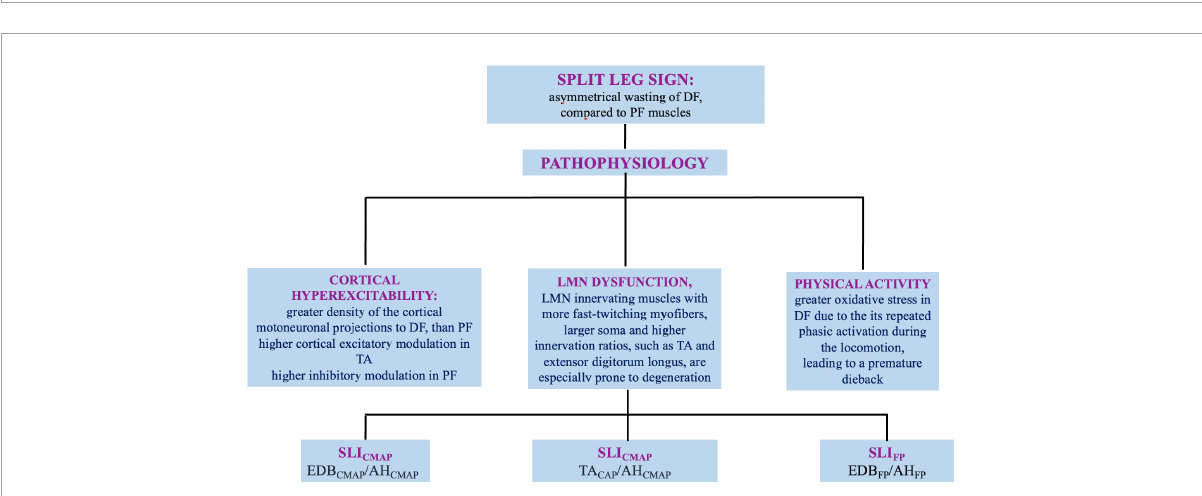
FIGURE2 Split leg sign in ALS: definition, pathophysiology, and neurophysiologic indexes. DF, dorsal flexors; PF, plantar flexors; LMN, lower motor neuron; SLI, split leg sign; CMAP, compound muscle action potential; EDB, extensor digitorum brevis; AH, abductor hallucis; TA, tibialis antherior; SLIFP, SLI derived from